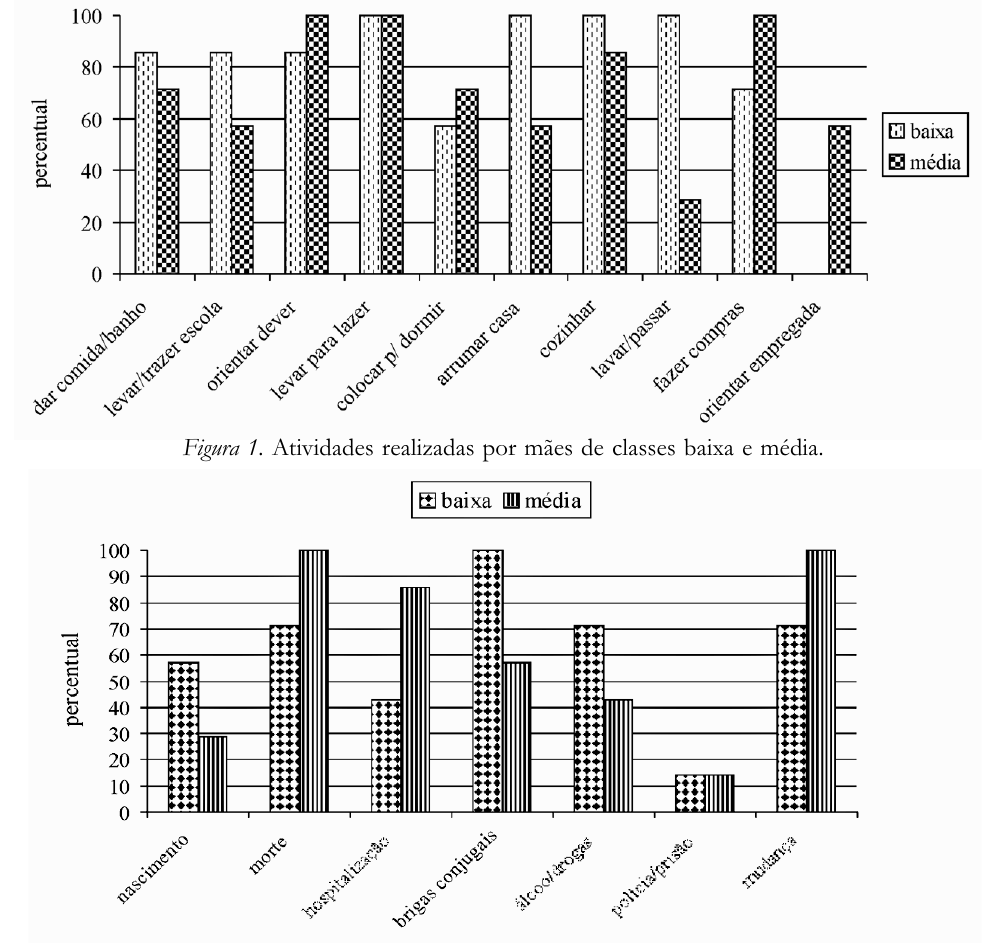
Figura 2. OcorrŒncia de eventos normativos e nªo-normativos, por classe social.